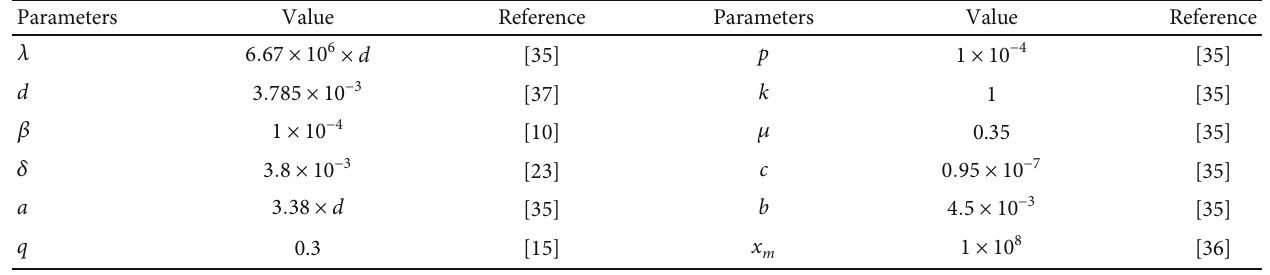
Table 1: The numerical value of the parameters for